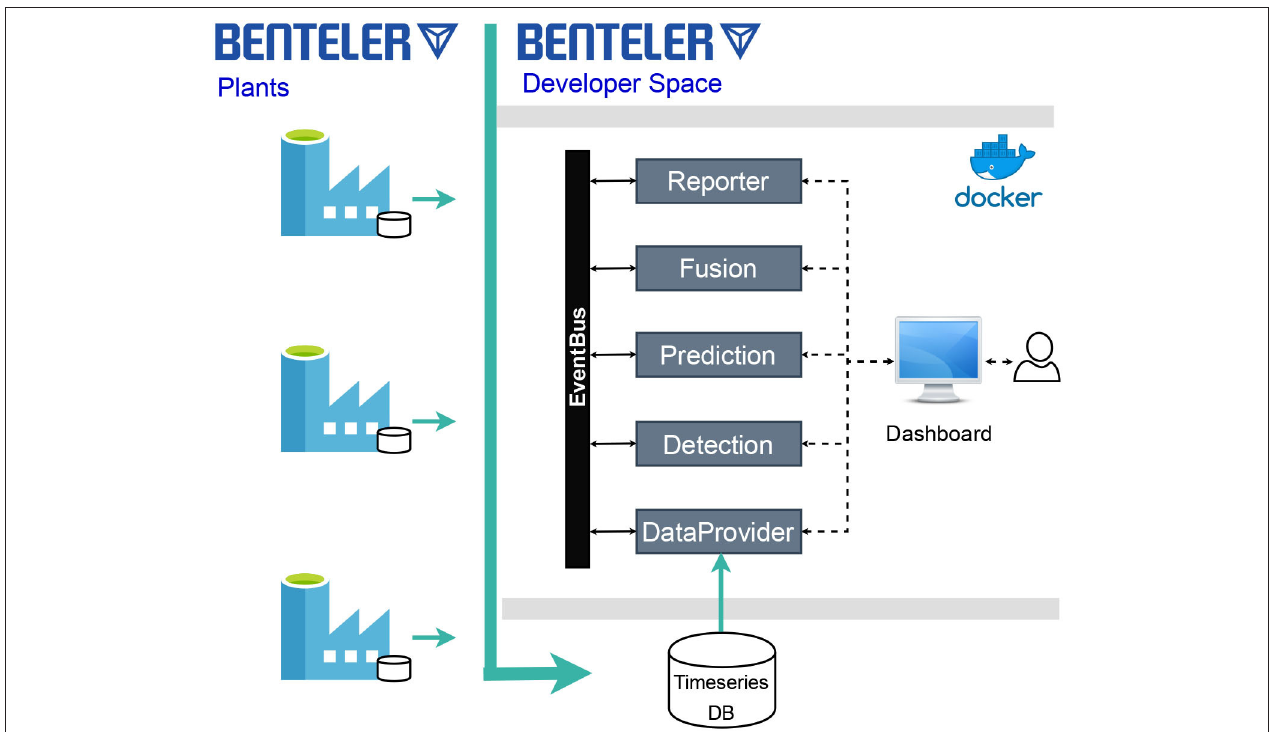
FIGURE 7 | BENTELER data infrastructure for smart